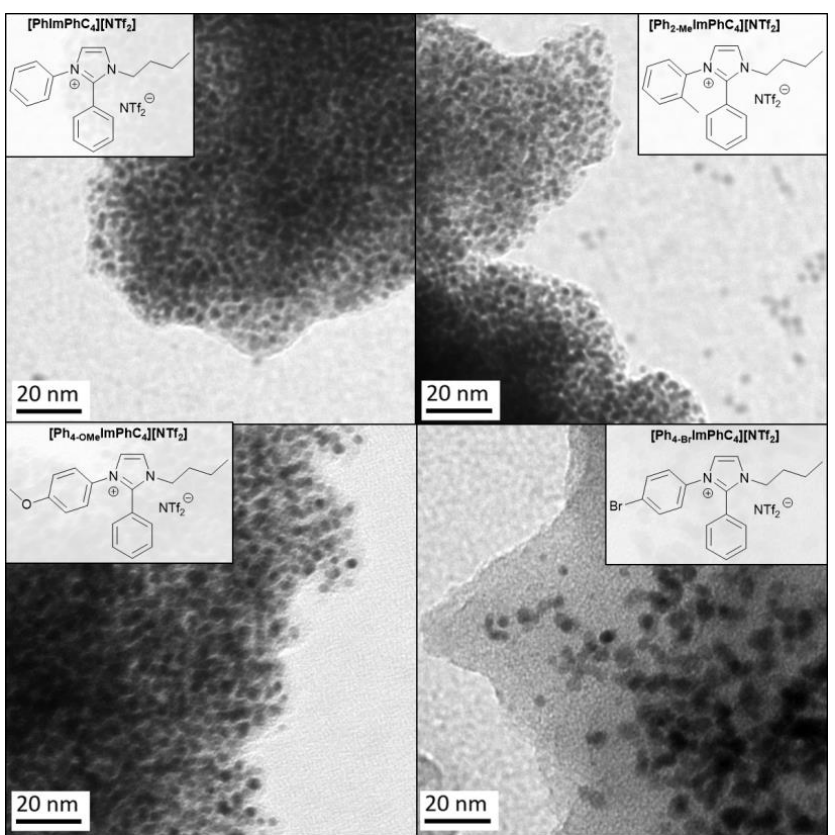
Figure 3. TEM images of (TAAIL)Pt-NPs obtained in the (non-C2-substituted) TAAILs [Ph 4- (DFP4).